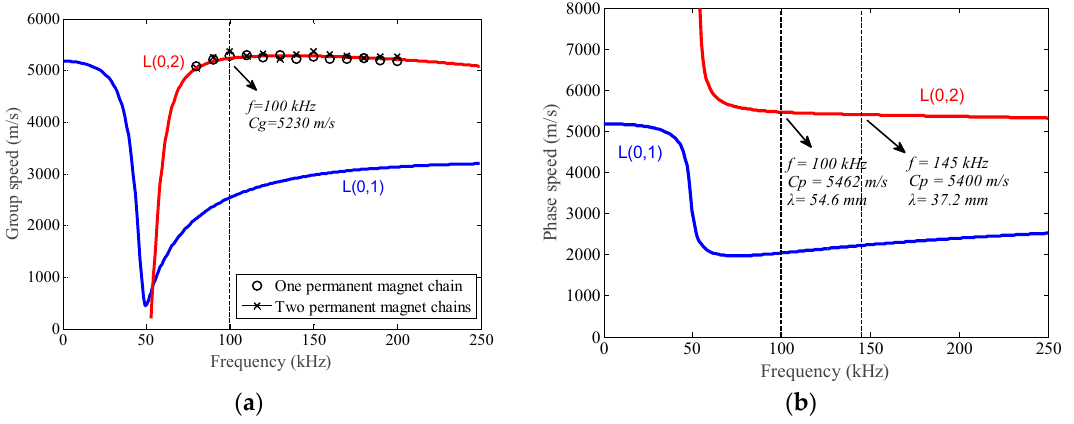
Figure 12. The dispersion curves of longitudinal modes for the tested pipe (steel 20) with the outside diameter of 38 mm and wall thickness of 5 mm through the Pcdisp ( a ) the group speed dispersion curve ( b ) the phase speed dispersion curve.